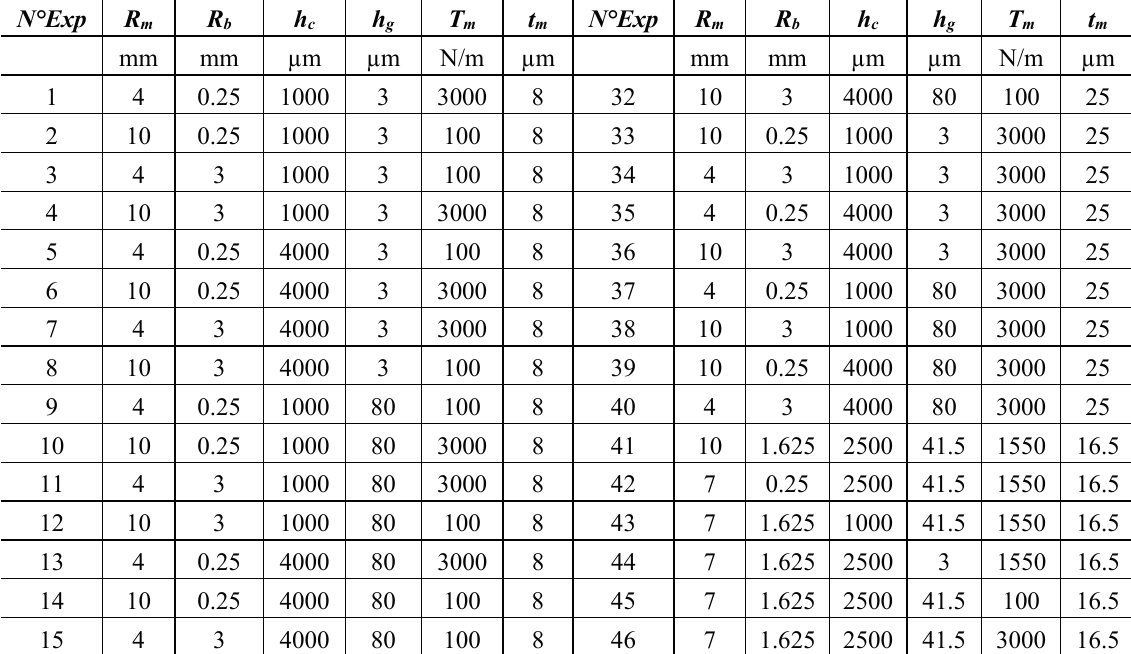
Table 4. DOE Table for acoustic sensor